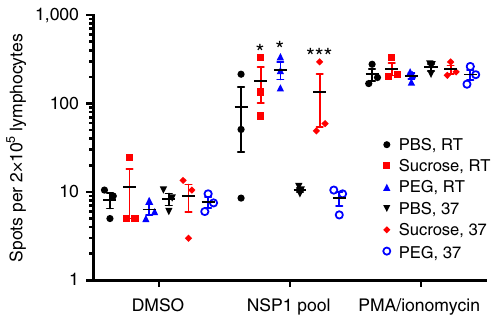
Figure 4 | In vivo experiments with stabilized Ad-NSP1 after 10 days of incubation in PEG or sucrose solution. Adenovirus vector expressing NSP1 from Chikungunya virus was incubated for 10 days at RTor at 37 (cid:2) C in PBS, 0.6M sucrose or 1 m M PEG. Mice were vaccinated by intramuscular injection of 100 m l of Ad-NSP1 from each stabilization condition ( n ¼ 3 per group). At 10 days post vaccination, mouse splenocytes were analysed by interferon gamma ELIspot for the frequency of T cells responding to NSP1 peptides. Ad-NSP1 stabilized in sucrose significantly increased the frequency of Tcells responding to NSP1. Photographs of the wells of ELIspot analysis can be found in Supplementary Fig. 8. Data are representative of two independent experiments. Centre values indicate the mean, and error bars represent the s.e.m. DMSO, dimethylsulphoxide; PMA, phorbol myristate